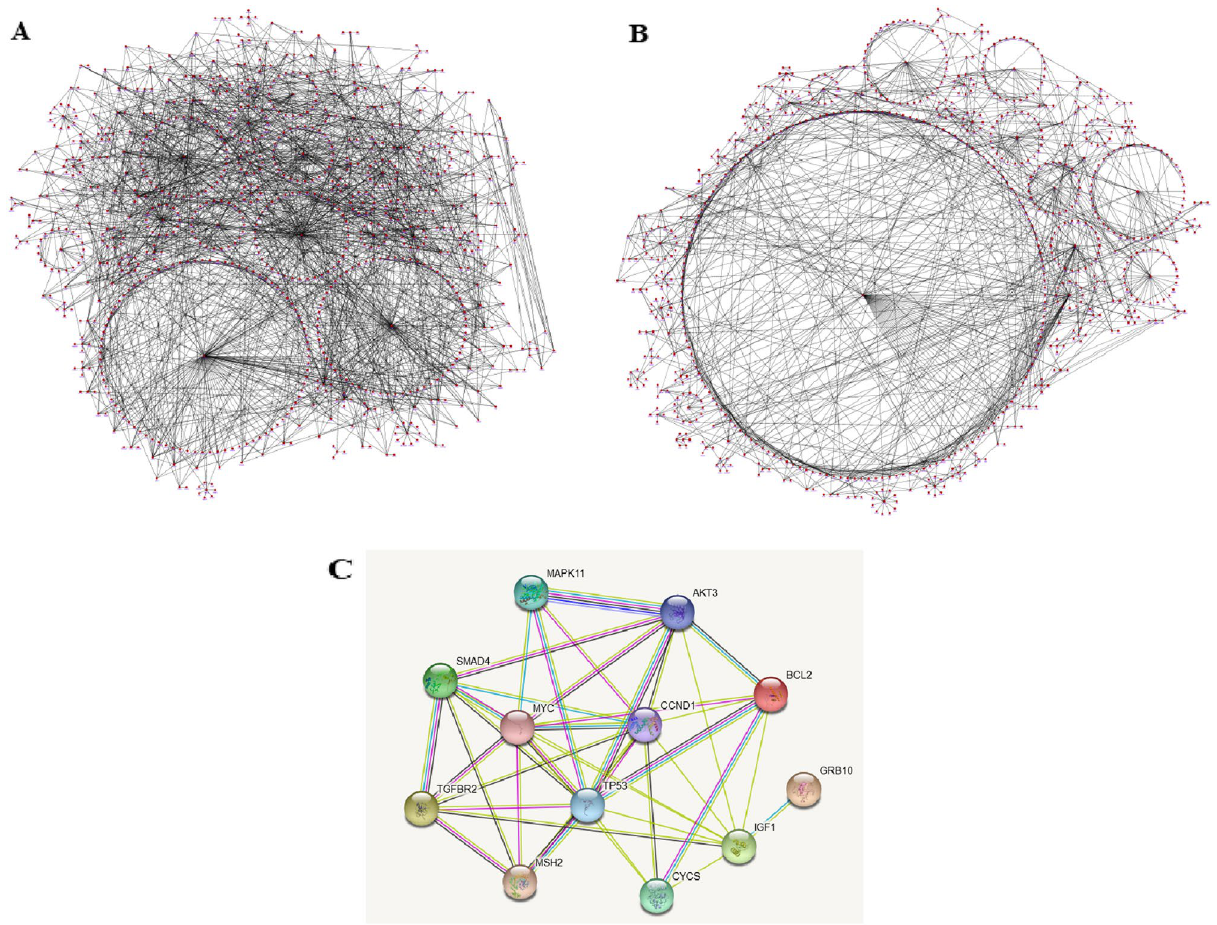
Figure 3 . Protein–protein interaction (PPI) network construction. PPI network was constructed with the DEGs of GEO and TCGA datasets. ( A , B ) The significant module was identified from the PPI network using the FunRich software with a score of ≥ 7. Panel ( A ) shows the interaction between 193 down-regulated genes. Panel ( B ) shows the interaction between 100 up-regulated genes. Panel ( C ) shows the interaction between up-and down-regulated selected